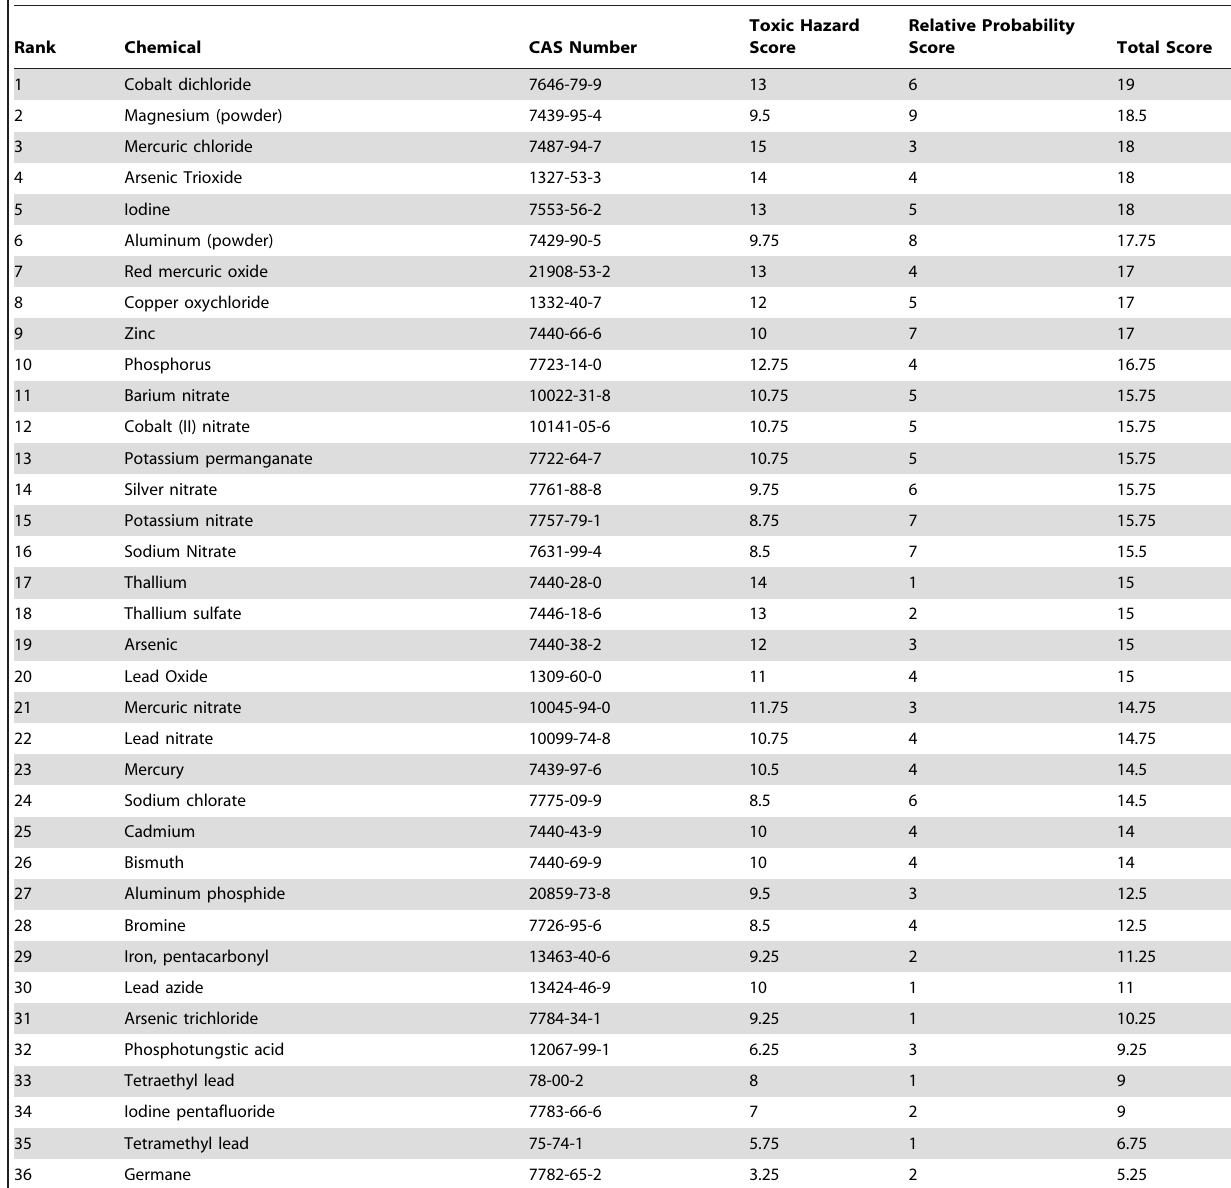
Table 1. Oral Toxicity